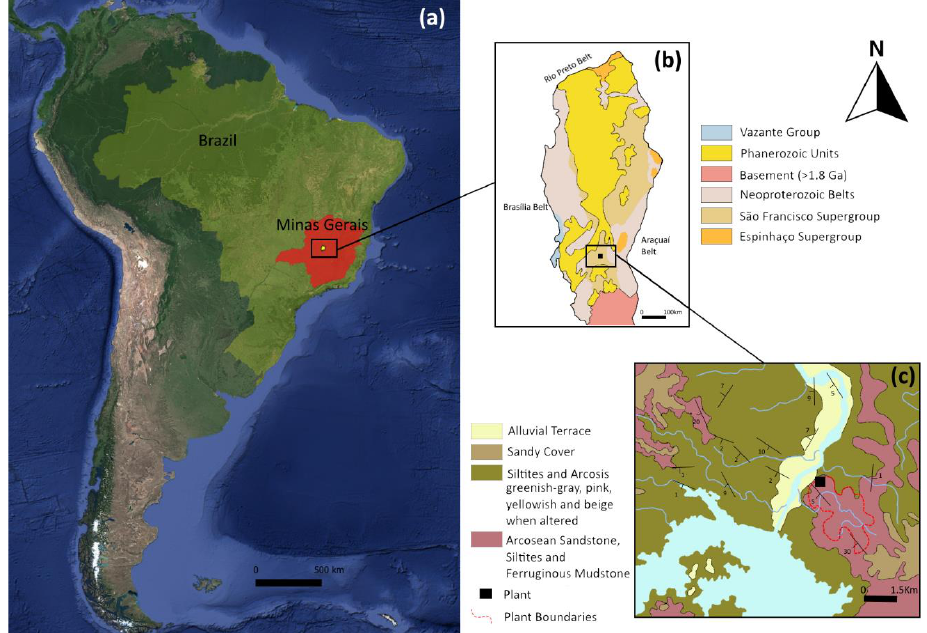
Figure 1. ( a ) Geographical location of the study area located in Minas Gerais state, South Brazil; ( b ) São Francisco Craton and its subdivisions; ( c ) geological setting and delimitation of the plant’s area of influence [2,3].